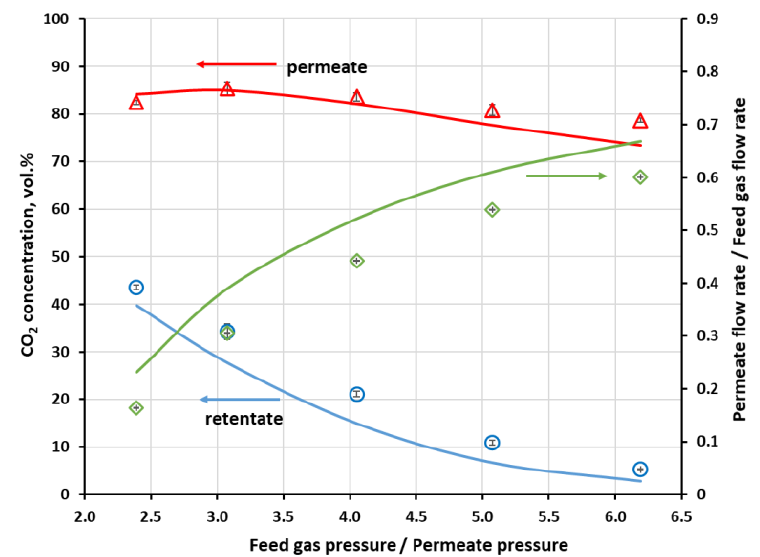
Figure 4. Experimental (points) and theoretical (lines) CO 2 concentration in the retentate and permeate, along with flux cut ratio against feed to permeate pressure ratio in Air Products PRISM PA1020 module. Feed gas flow rate: 0.038 kmol h − 1 ; composition of feed gas: CH 4 (50 vol.%)/CO 2 (50 vol.%); temperature: 295 K.